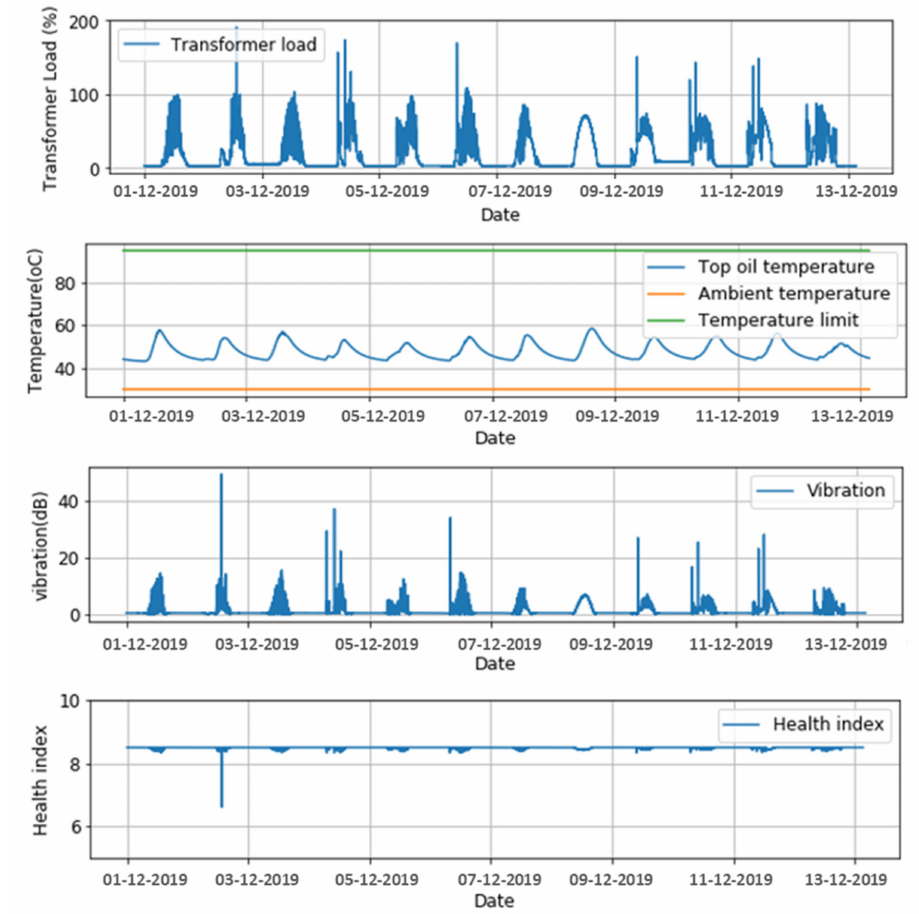
Figure 8. Test results of Scenario